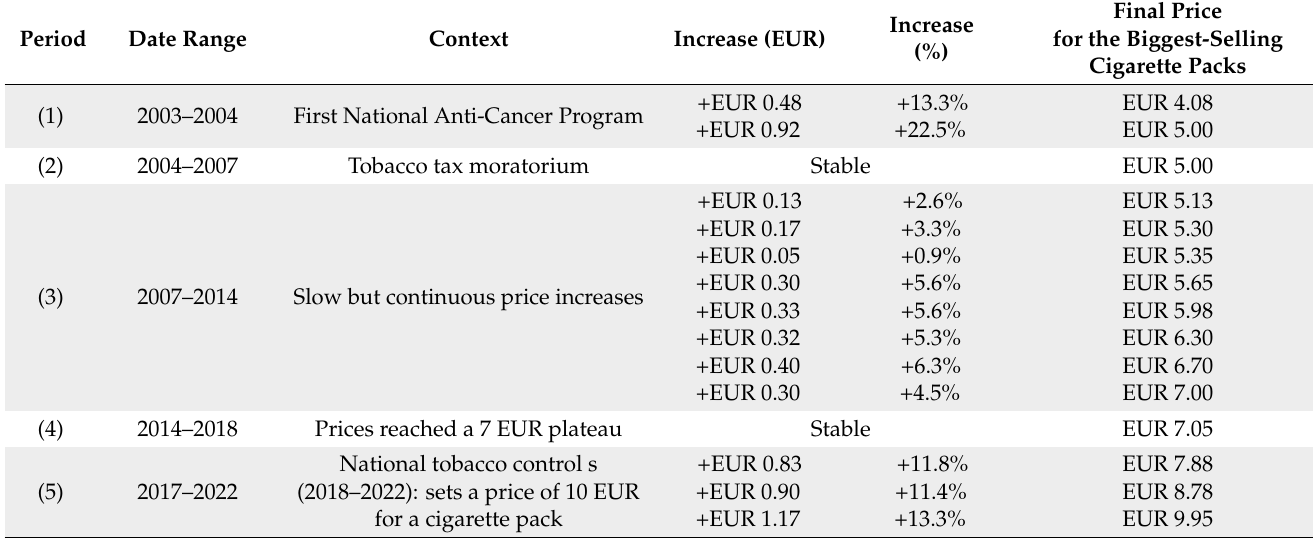
Table 1. Key periods of tobacco tax increase in France between 2000 and